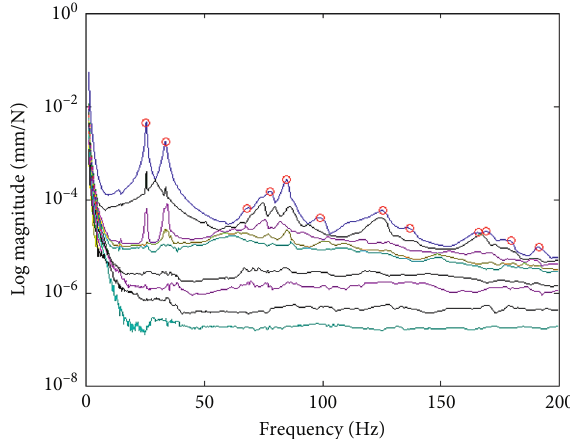
Figure 8: Peak-picking extraction in the singular value in Ref Case